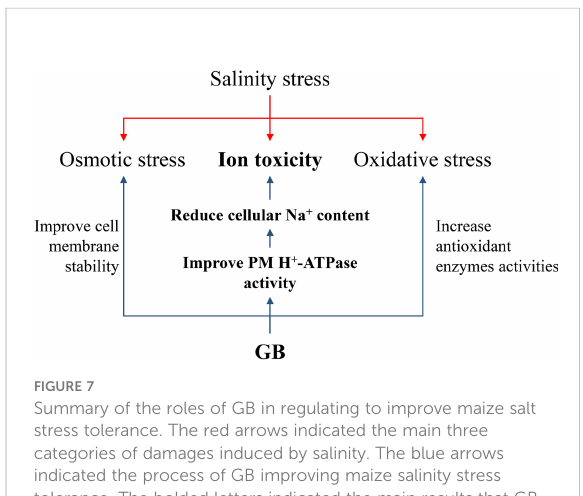
FIGURE 7 Summary of the roles of GB in regulating to improve maize salt stress tolerance. The red arrows indicated the main three categories of damages induced by salinity. The blue arrows indicated the process of GB improving maize salinity stress tolerance. The bolded letters indicated the main results that GB reduced maize cellular Na+ content by improving PM H +-ATPase activities to alleviate ion toxicity induced by salinity.